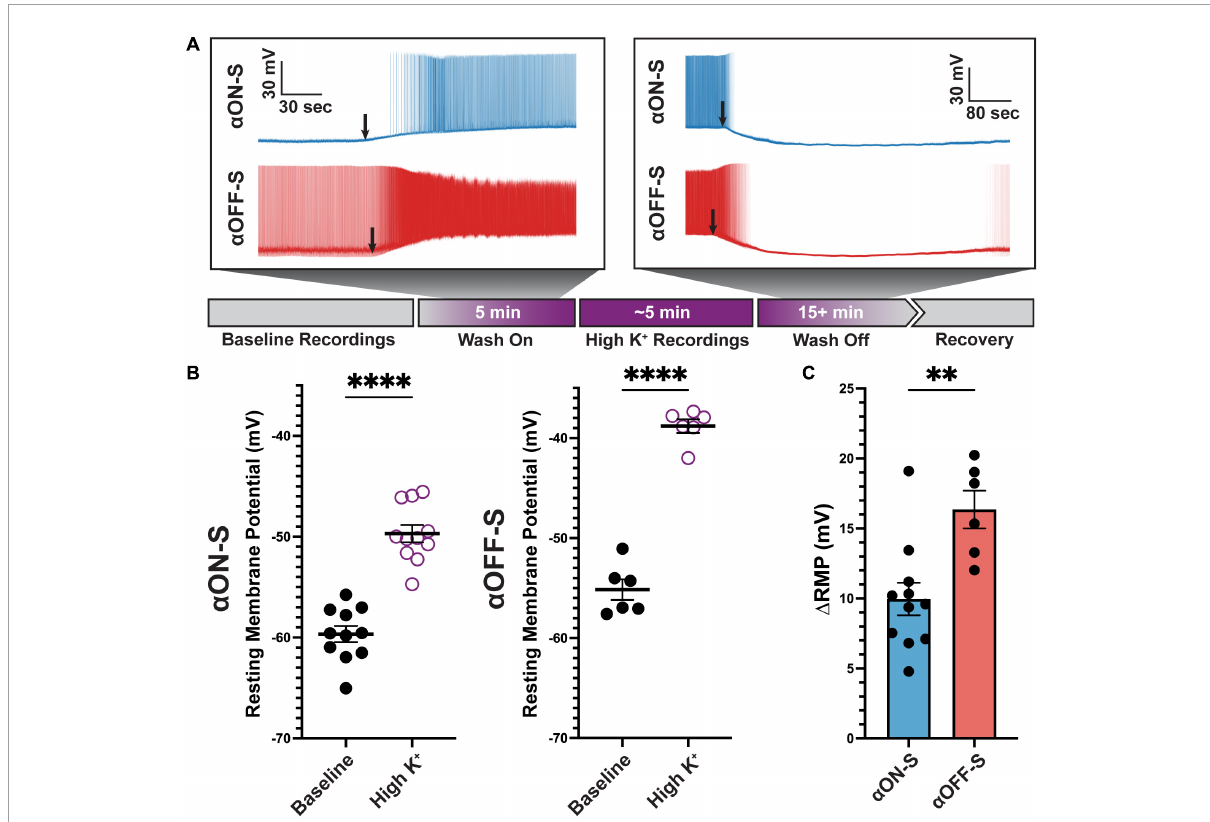
FIGURE4 Alpha OFF-sustained ( α OFF-S) cells are more depolarized by elevated extracellular potassium. (A) Schematic timeline of experiment, and representative spontaneous voltage responses of alpha ON-sustained ( α ON-S) and α OFF-S cells during high K + medium (additional 5 mM KCl) wash on and off. Black arrows indicate onset of significant depolarization (left) or repolarization (right). (B) Resting membrane potentials (RMP) measured for each cell before and after addition of 5 mM KCl. High K + significantly depolarized both α ON-S and α OFF-S cells (paired t -tests, p < 0.0001 for both). (C) Change in RMP ( (cid:49) RMP) after high K + addition. (cid:49) RMP was significantly greater for α OFF-S cells (unpaired t test, p = 0.0038). Error bars: ± standard error of the mean. ∗∗∗∗ p < 0.0001, ∗∗ p <